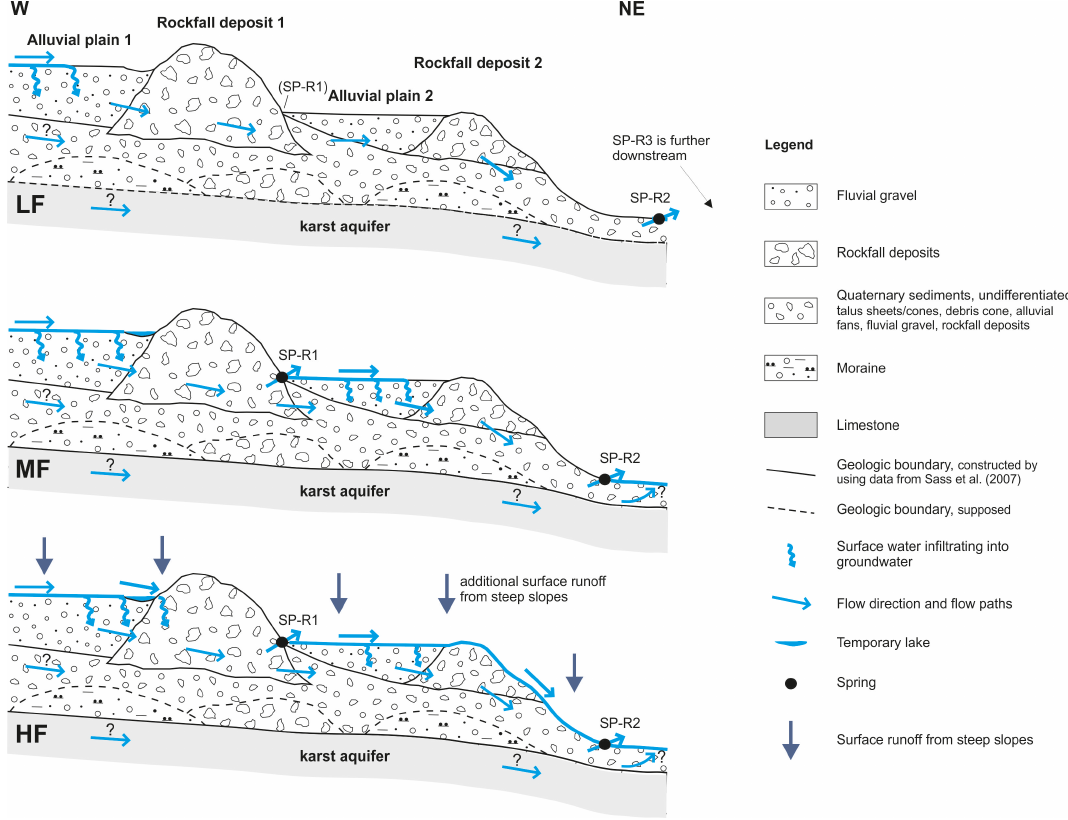
Figure 6. Conceptual model of surface and groundwater flow in the series of alluvial/rockfall aquifers of the Reintal under low-, moderate-, and high-flow conditions (LF, MF, and HF, respectively. The tracer injection in 2011 was done under high-flow conditions. The length of the section is 1.5km and is vertically exaggerated.